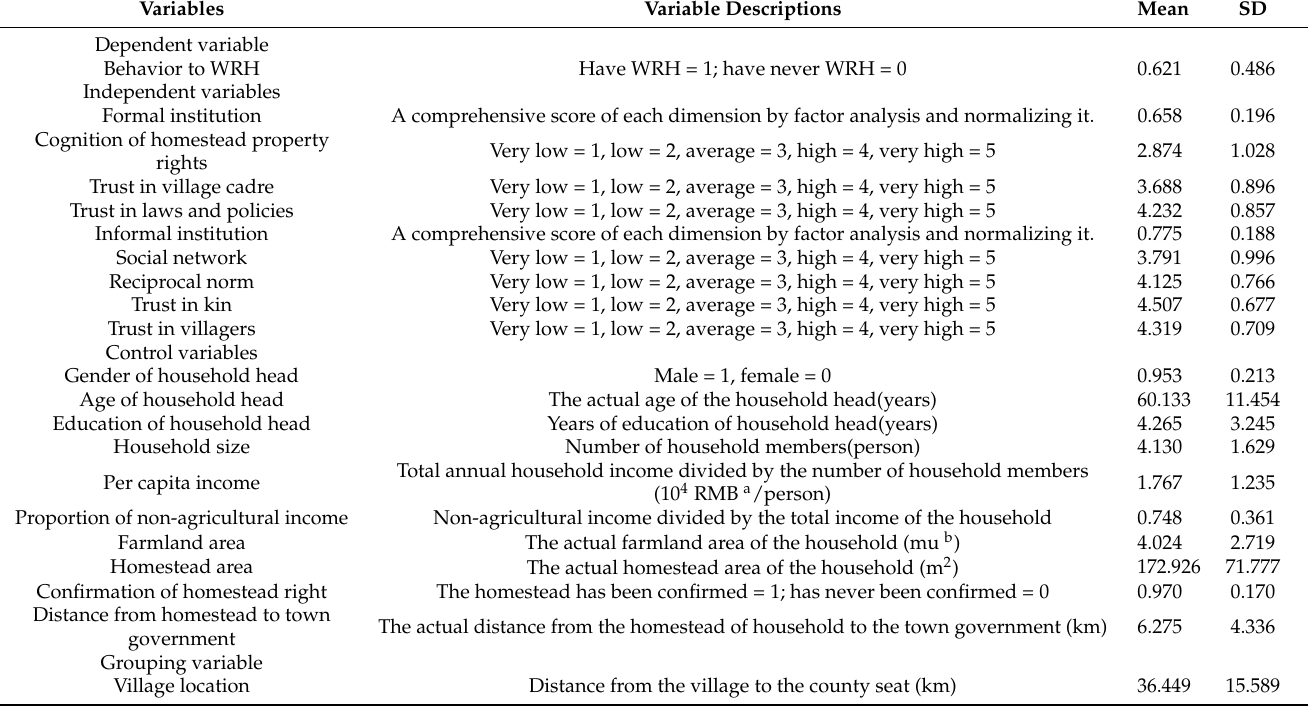
Table 2. Variables, assignment, and